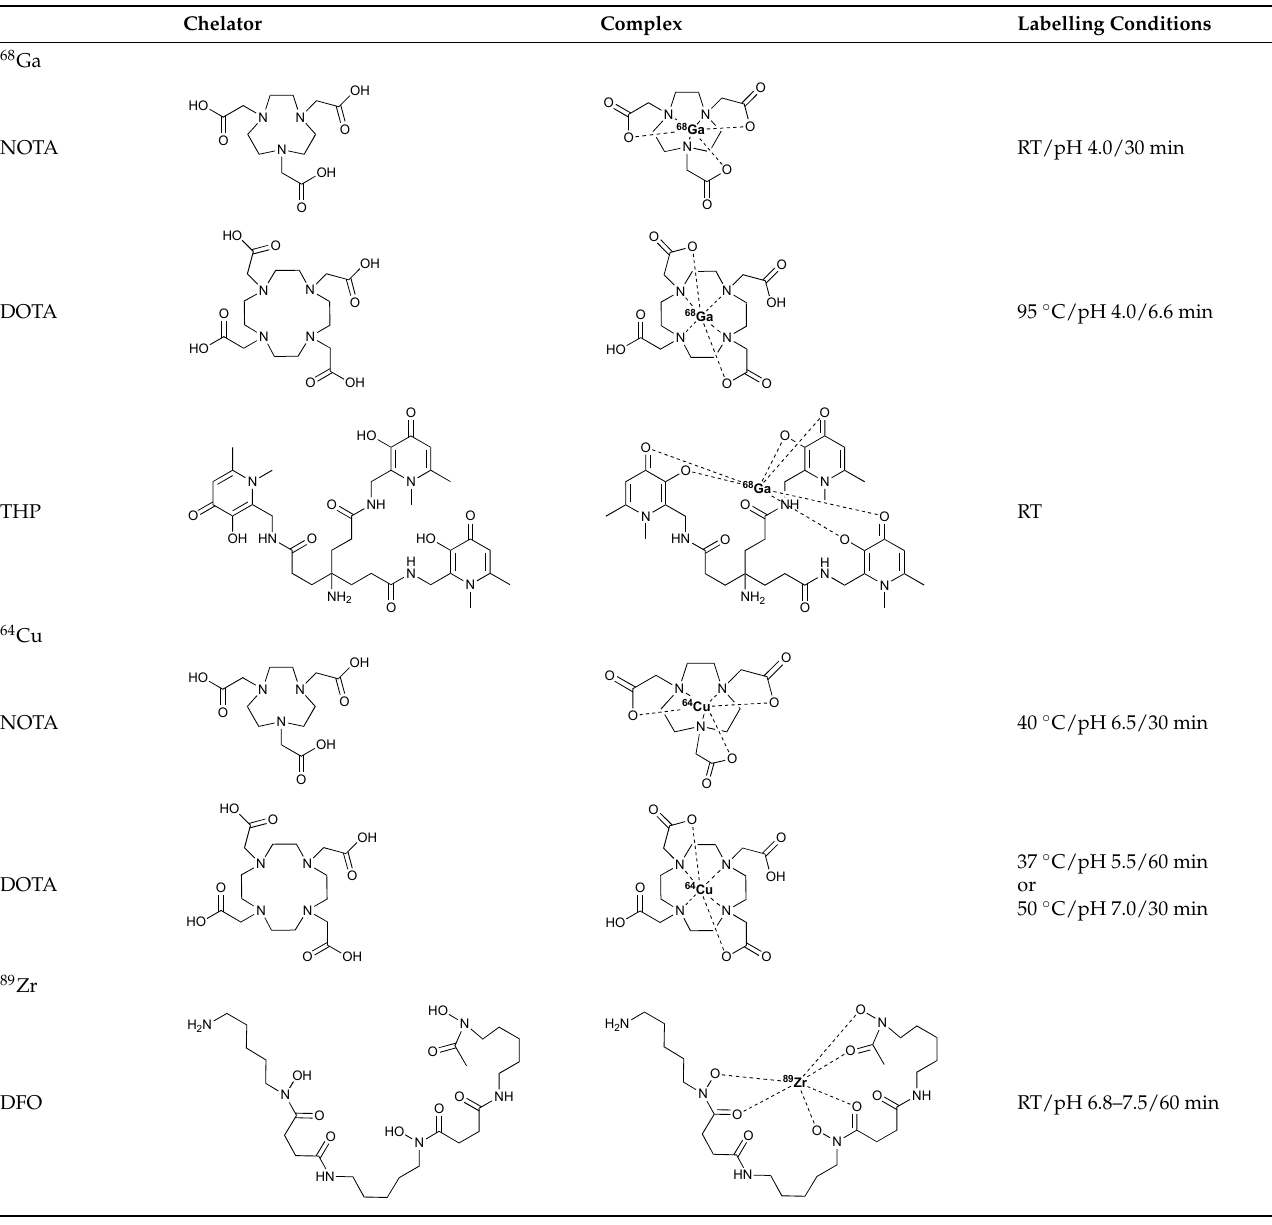
Table 2. Radionuclides and their corresponding chelators. Complex Labelling